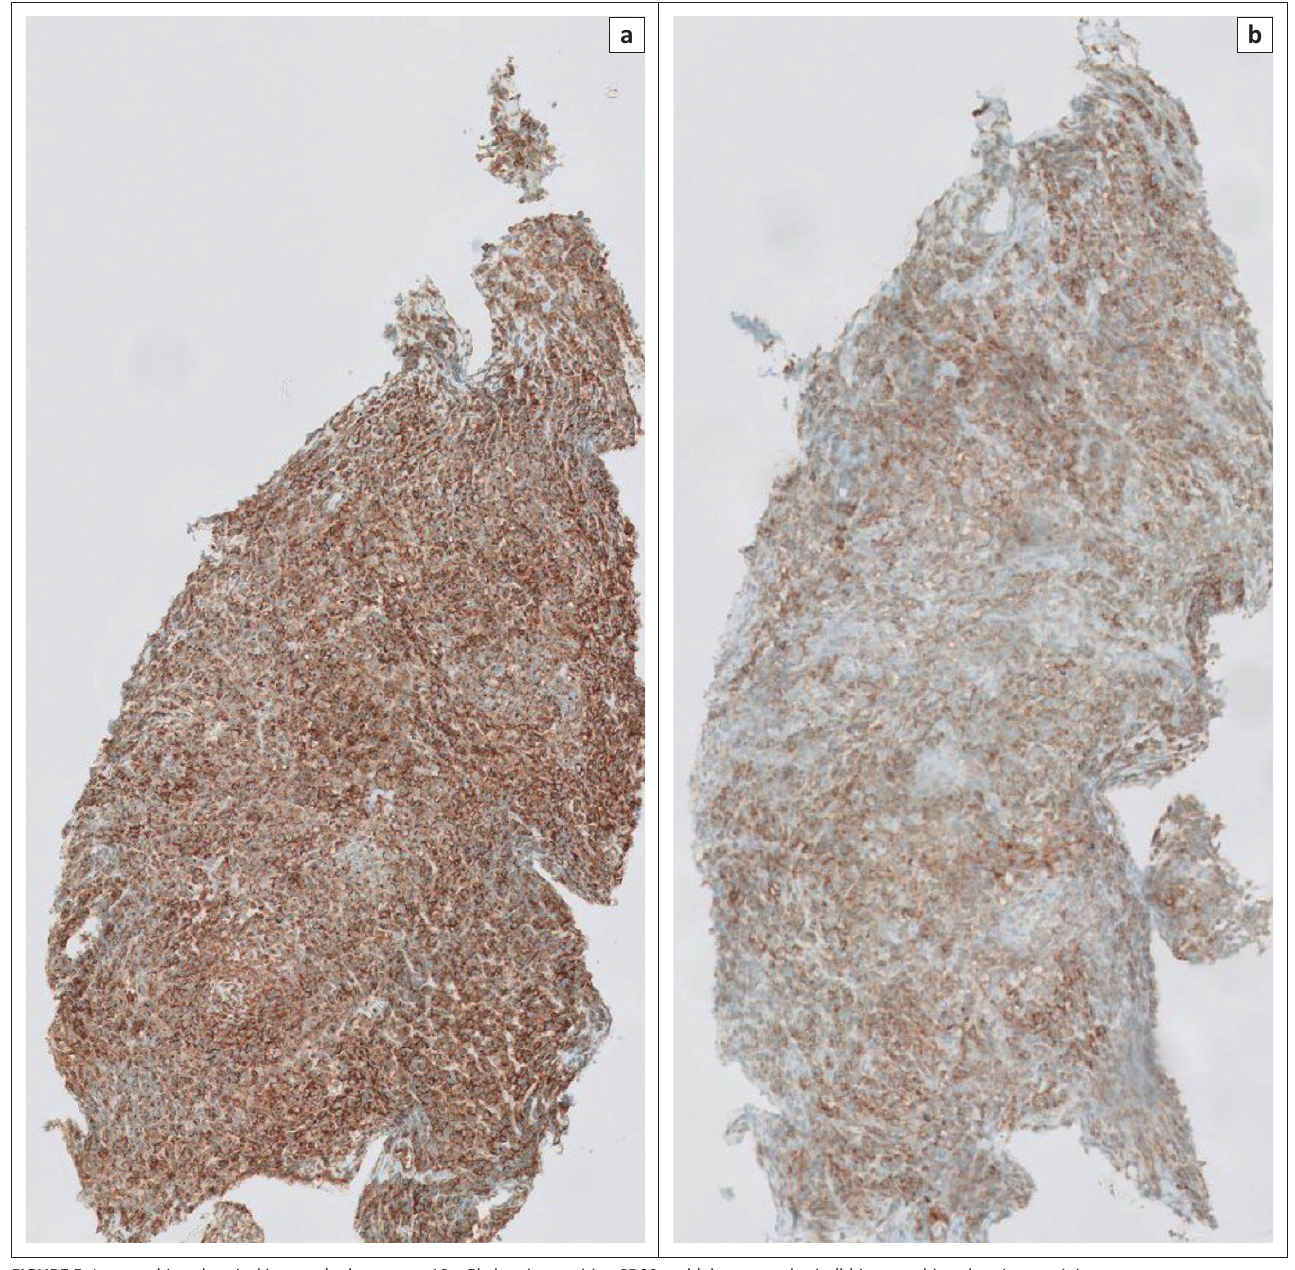
FIGURE 5: Immunohistochemical images (enlargement 10 × 5) showing positive CD99 and (a) synaptophysin (b) immunohistochemistry